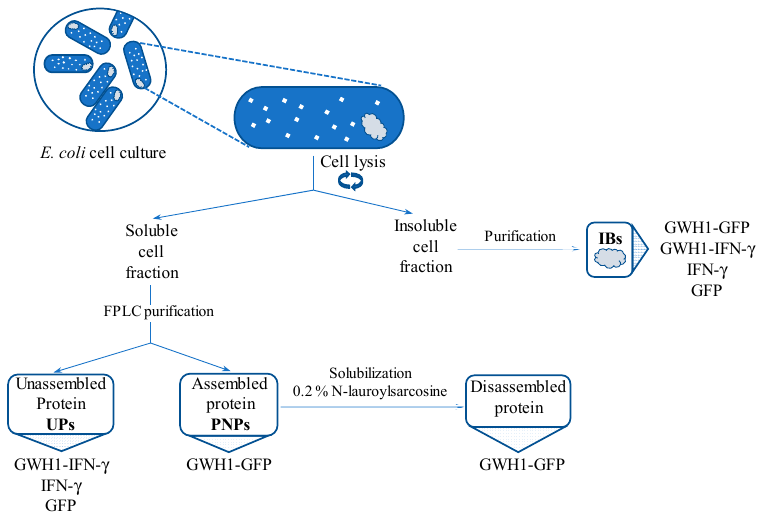
Scheme 1. Schematic representation of the protein formats used through the study. During protein production, recombinant protein was accumulated inside E. coli cells as insoluble aggregates (inclusion bodies—IBs) or in a soluble state. After cell lysis and centrifugation, IBs were recovered from the cell debris. Supernatant was used for soluble protein purification purposes. Positive protein peaks were analyzed by dynamic light scattering (DLS) and protein samples were categorized as unassembled protein versions or assembled protein versions. Assembled protein GWH1-GFP was transformed into disassembled protein by incubation with mild detergent. The names of the protein samples used in the mastitis mice model are labeled beside or below the protein versions enclosed in a light blue box.